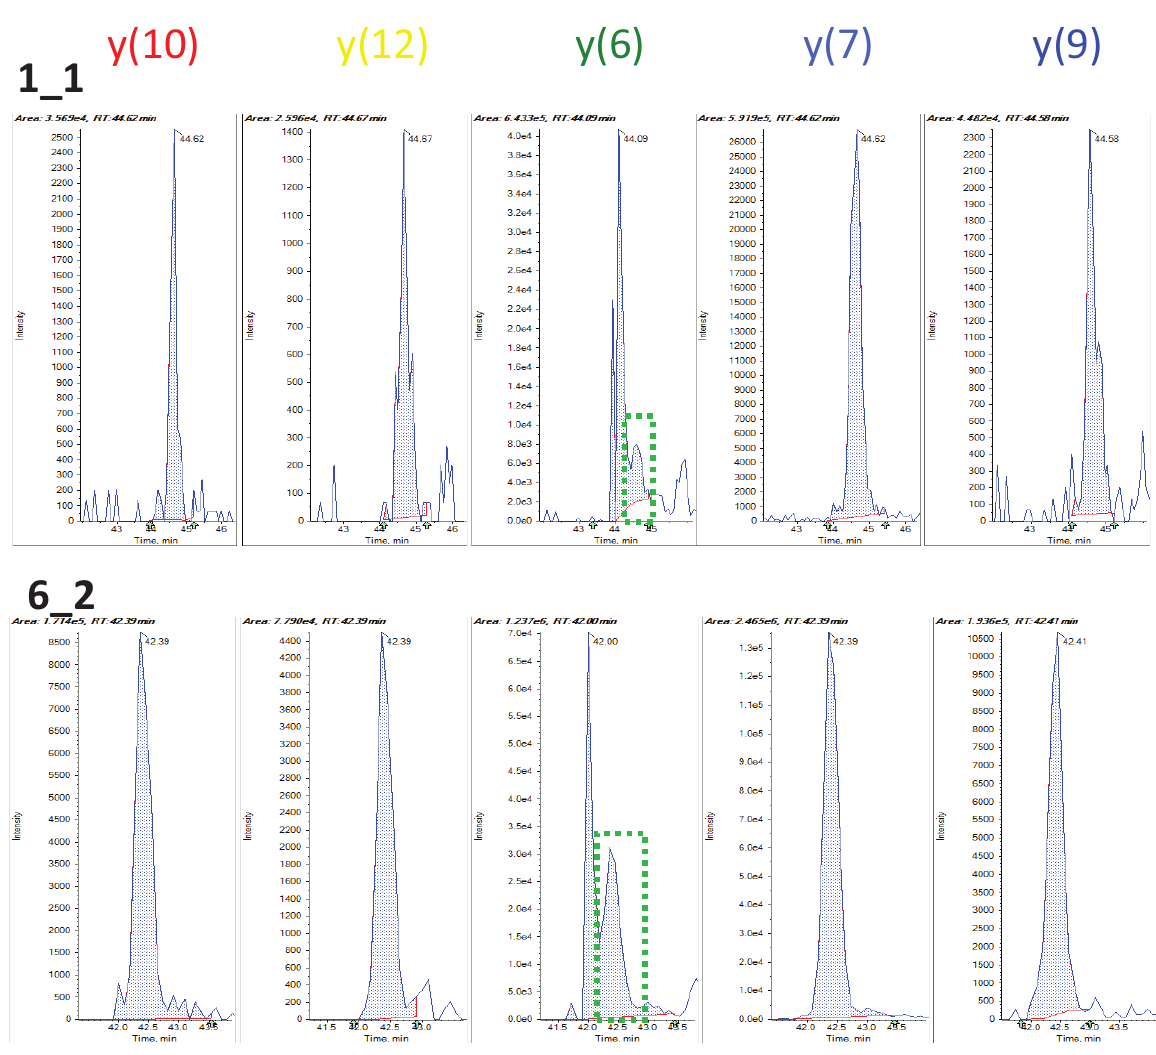
Figure 4. Peak shapes from two runs in PSD data from the same peptide as in Figure 2. Middle panel shows the peaks of a problematic transition by median weight by robust regression. Green dotted boxes show correct peak candidates.